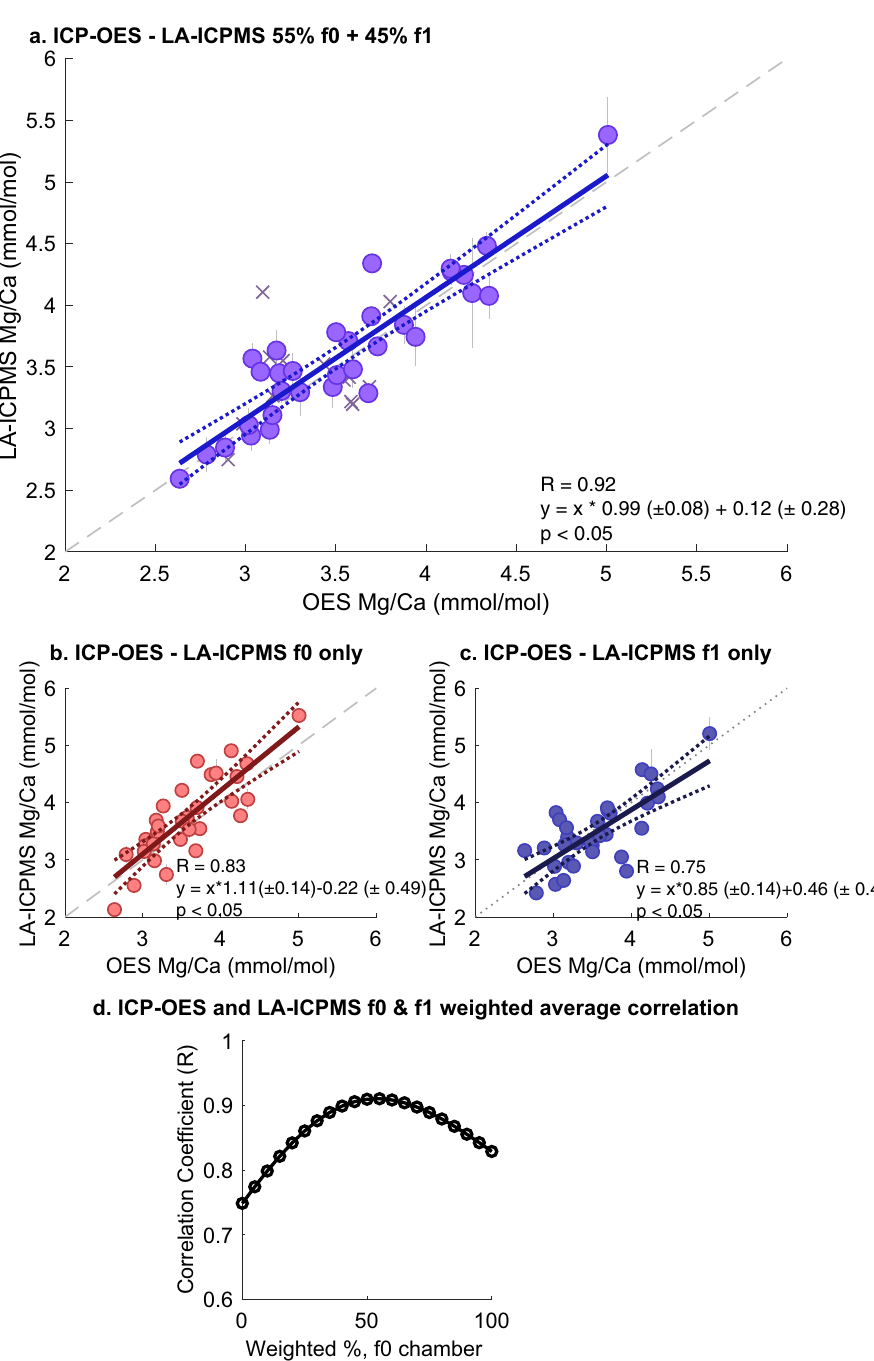
Figure 8. Correlation between ICP-OES and LA-ICPMS Mg/Ca values from paired analysis on the same individuals. Each point in a-c represents a single individual analyzed via both ICP-OES and LA-ICPMS. ( a ) The correlation between ICP-OES Mg/Ca values and the LA-ICPMS derived Mg/Ca using a weighted average of 55% f0 and 45% f1 chamber values (N = 32). ( b , c ) show the relationship between ICP-OES Mg/Ca and LA-ICPMS derived Mg/Ca using only the f0 or f1 chamber values. f2 chamber values (not shown) are similar to f0. ( d ) The correlation coefficient (R) obtained using different weightings of the f0 and f1 chamber. Maximal correlation (e.g., maximum R value, y-axis) occurs at 55% f0 (x-axis) and 45% f1